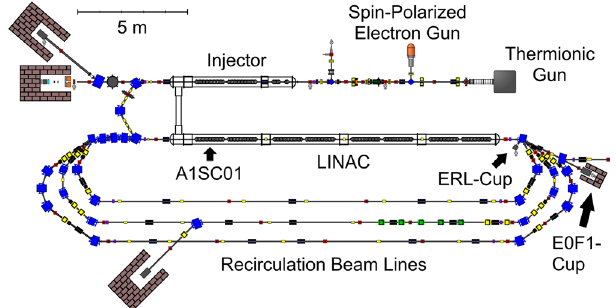
FIG. 2. Schematic floorplan of the